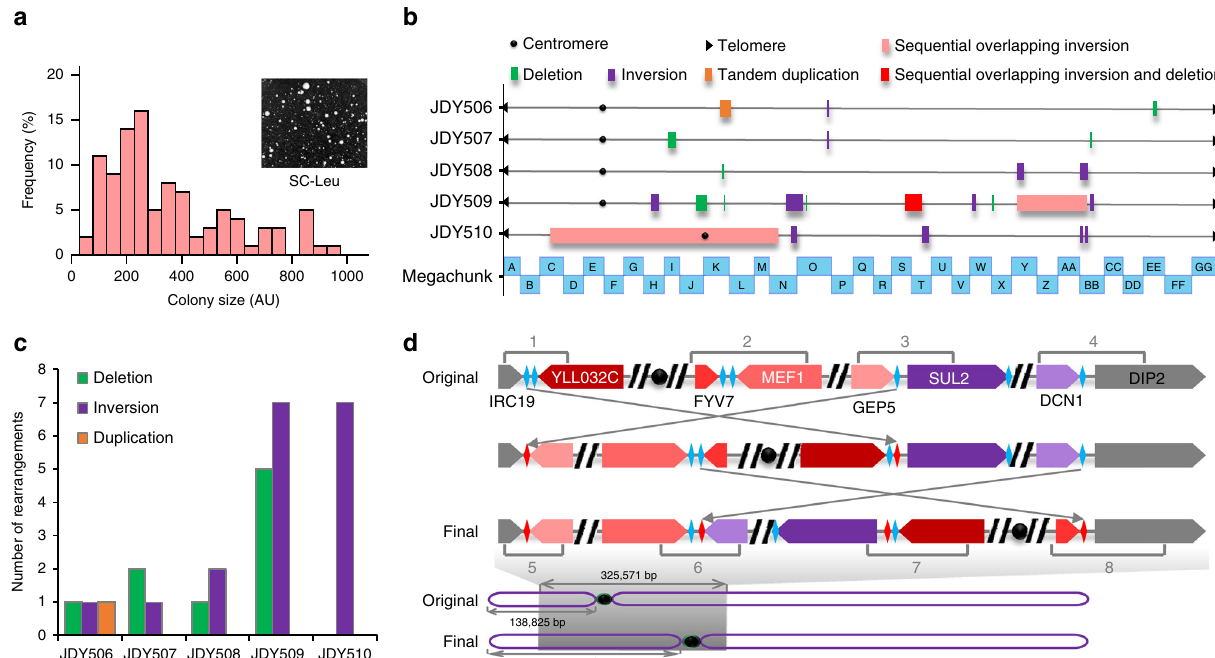
Fig. 2 Selection and characterization of SCRaMbLEd strains with ReSCuES. a Distribution of sizes of SCRaMbLEd synXII clones with ReSCuES integrated at HO locus. The colony sizes of 100 Leu + colonies were determined by ImageJ. AU, arbitrary units. b Rearrangements of synXII in fi ve randomly selected colonies. Different types of rearrangements were labeled by different color. The relative size and position were indicated using the synthetic megachunks as reference. The detailed information of each rearrangement was showed in Supplementary Figs. 3 – 7. c The numbers of different rearrangements identi fi ed in the fi ve strains. d The largest inversion (the shadow area) was found in JDY510 that altered the relative location of centromere. The potential recombination events producing the rearrangement were illustrated. The number indicates the PCR amplicons used to verify the